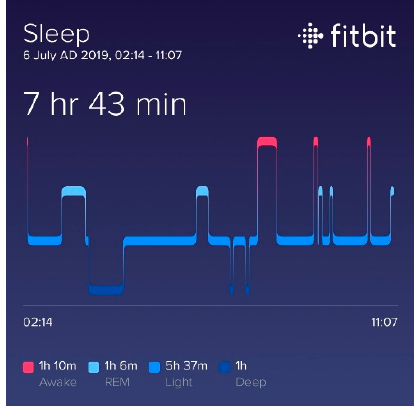
Figure A10. Milan, Italy.